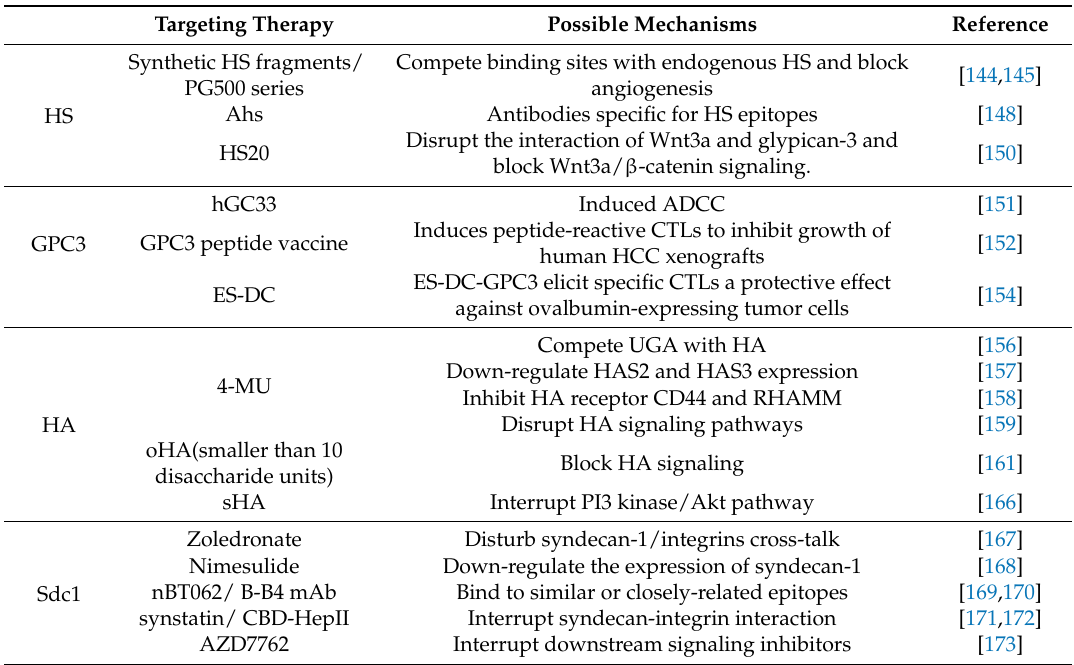
Table 2. Glycocalyx-targeting therapeutic